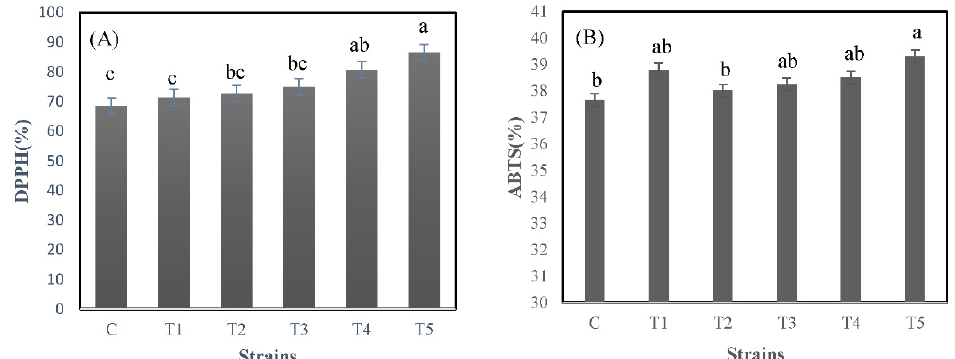
Figure 3. ( A ) DPPH and ( B ) ABTS radical scavenging assays of the water-soluble extracts (WSEs) from yogurt. C, control yogurt without probiotics; T1, L. rhamnosus GG KCTC 12202BP; T2, L. plantarum KU15003; T3, L. plantarum KU15031; T4, L. plantarum NK181; T5, L. delbrueckii KU200171. Means from different yogurt expressed by lowercase letters (a–c) are significantly different ( p < 0.05).